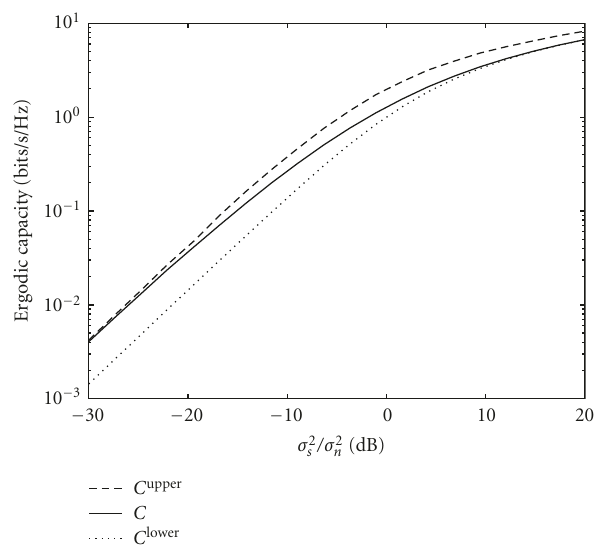
Figure 9: Ergodic capacity with upper and lower bounds in an interference limited, single-user system with m = 3 degrees of